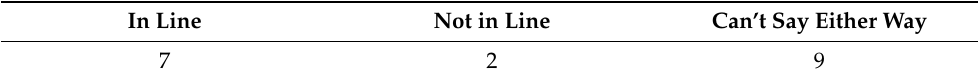
Table 5. Evaluation of HRC activities.